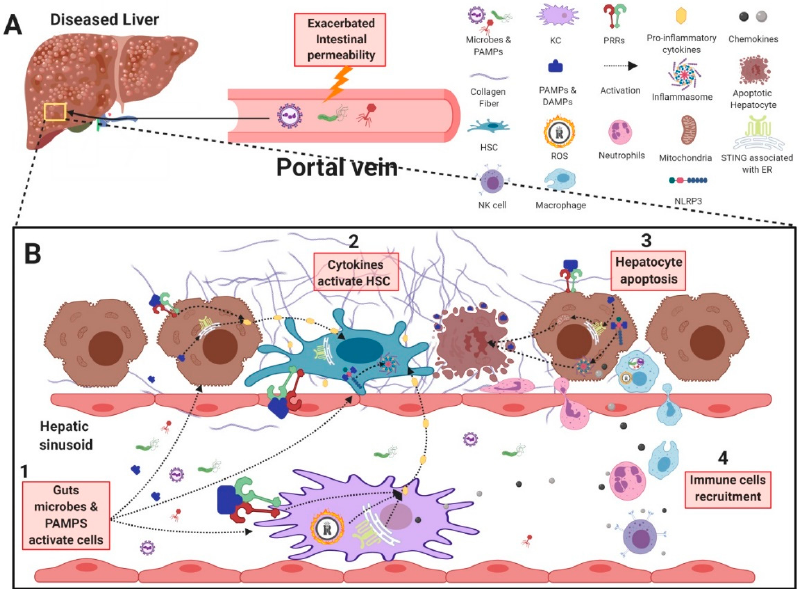
Figure 2. Gastrointestinal microbes and their contribution to liver inflammation and fibrosis. ( A ) In chronic liver disease, gut microbes and PAMPs can cross the intestinal barrier due to an increase